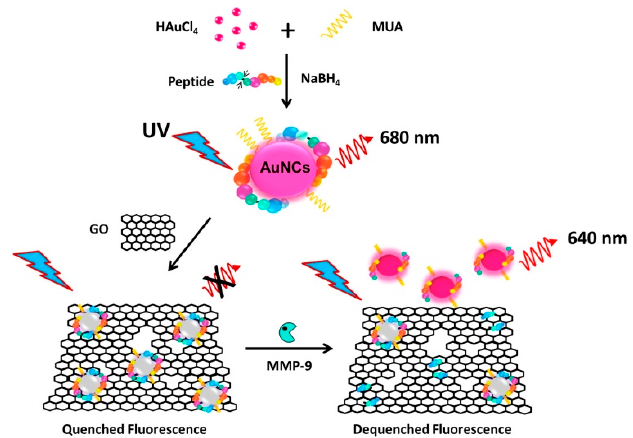
Figure 2. Diagram of peptide-AuNCs-GO nanocomplex for the detection of MMP-9 enzyme. Reprinted with permission [41], Copyright 2015 Elsevier B.V.